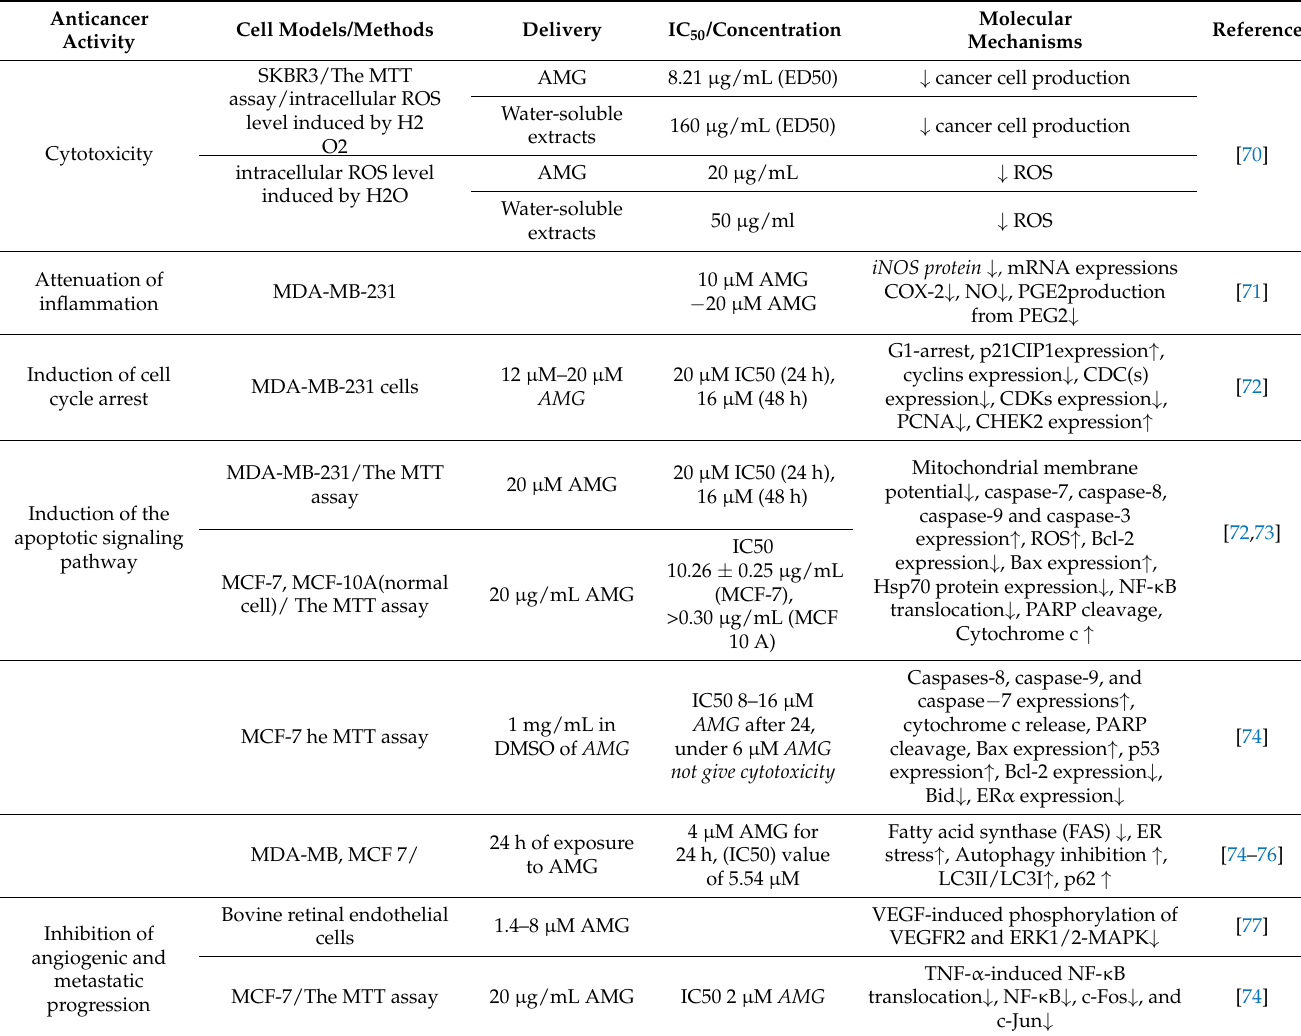
Table 1. Pharmacological effects of AMG in